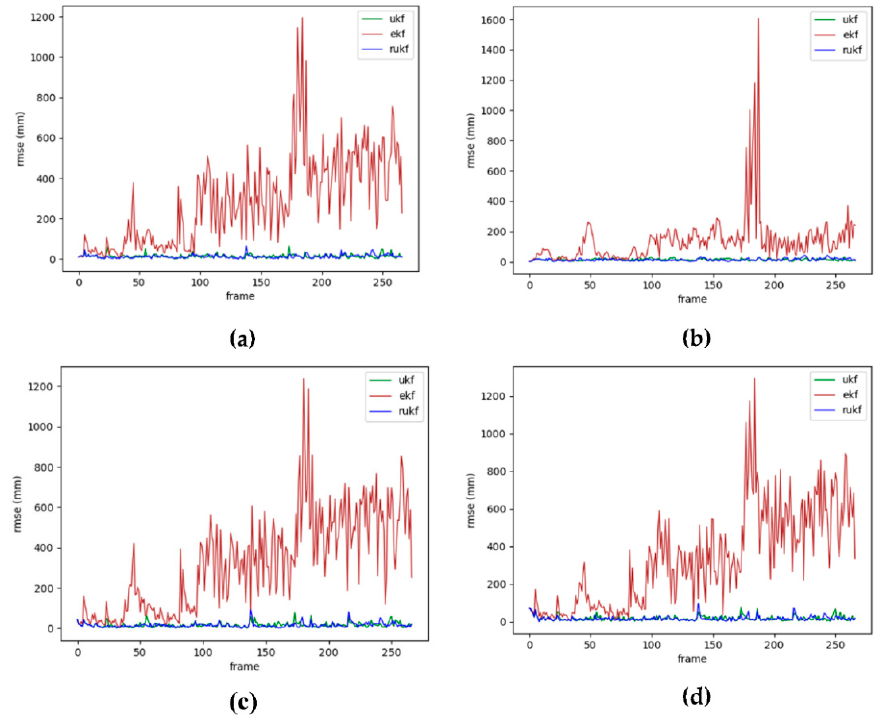
Figure 3. Comparison of the RMSE results of EKF, UKF, and proposed method; ( a ) Pelvis, ( b ) Spine_ navel, ( c ) Head, and ( d ) Nose. Joints of each pose are affected by the noise; the effected nonlinear temporal noise was filtered with nonlinear filters. Further, the EKF has the largest RMSE at the ear_right (5.83 ± 17.63) and the smallest RMSE at the pelvis (1.34 ± 0.57). Utilizing the UKF method, RMSE at the ear_right is (4.63 ± 15.6) and the value of the pelvis is (0.58 ± 0.40), the data demonstrate that there is a possibility to reduce the noise further. Finally, upon imple- menting the proposed method, the RMSE value for “ear_right” was found to be (1.60 ± 4.78), and the RMSE value for the pelvis was found to be (0.35 ± 0.26). Specifically, parts of the head including ‘eye_right’ and ‘ear_right’ moved more rapidly than the other joints of the body. This resulted in an increase in the SD compared to the other joints.